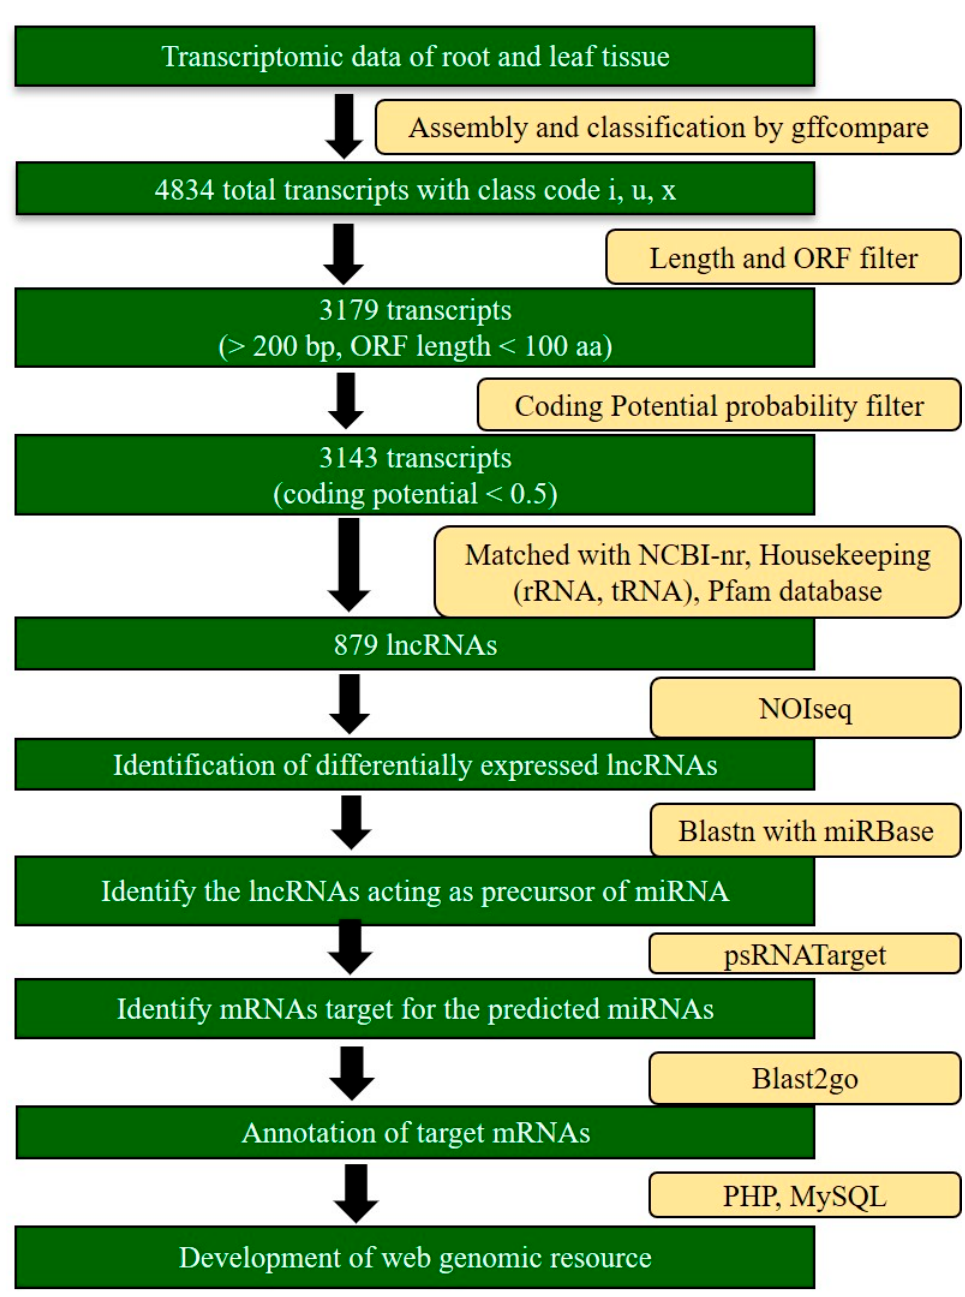
Figure 1. Schematic diagram for identification of lncRNAs, annotation of target mRNAs and devel- opment of web genomic resource.